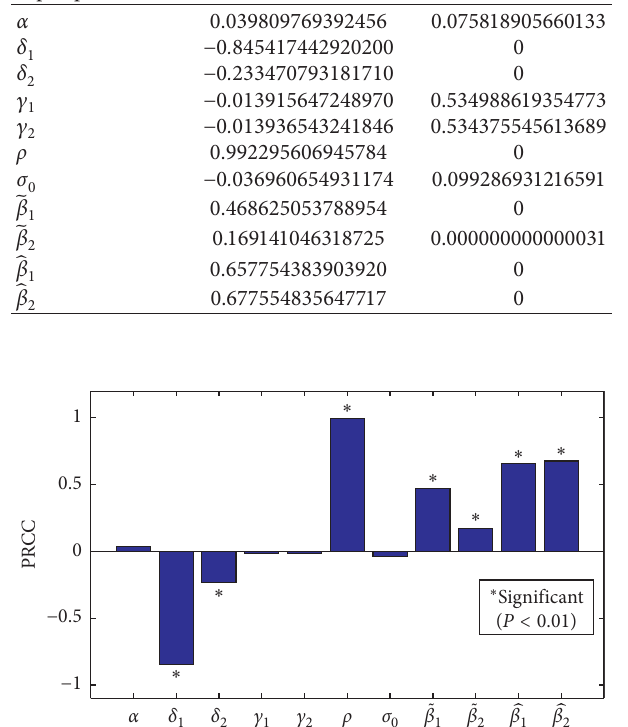
Figure 5: The values of PRCC on the outcome of R values are derived from Wenzhou city in Table